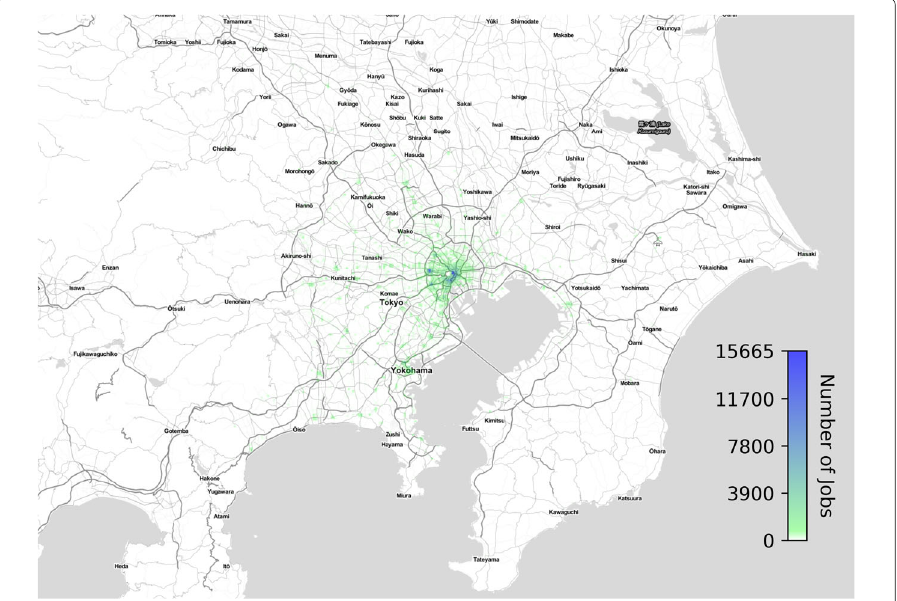
Fig. 2 A map of the Tokyo area used in the analysis with the hex grid overlay showing the employment engagements (i.e., jobs) data. Map tiles by Stamen Design (2019), map data by OpenStreetMap Contributors